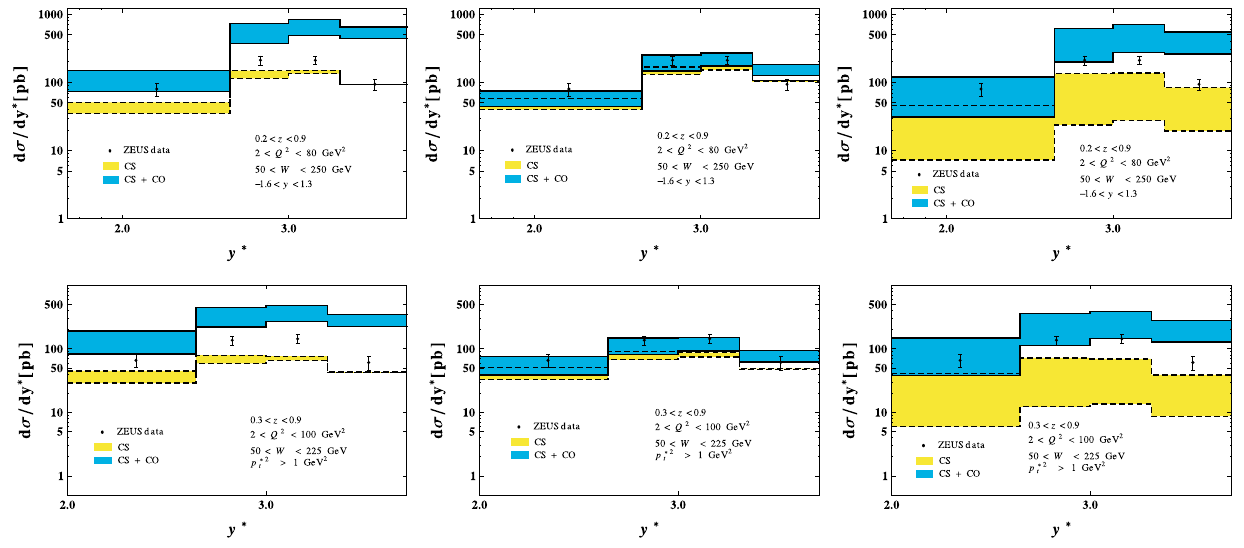
Fig. 13 The differential cross sections for the J /ψ production in DIS with respect to y (cid:11) ψ . The experimental data are taken from Ref. [49]. The l.h.s., middle, and r.h.s. plots correspond to the LDMEs taken in Refs. [28,30,41], respectively